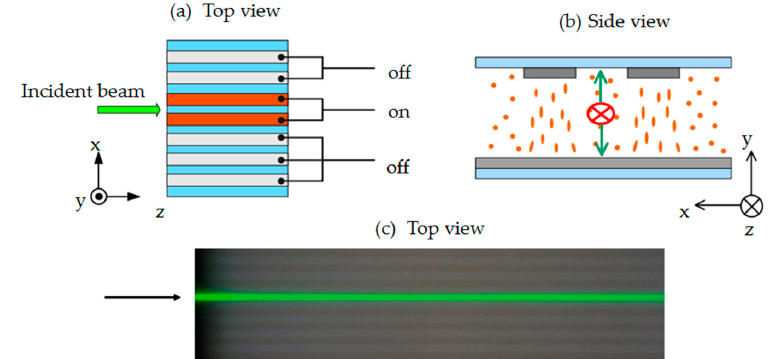
Figure 5. The incident beam is introduced into a non-electrode channel, ( a ) top view and ( b ) back view of the schematics for the incident beam and the sample schematic. ( c ) The top view image captured by camera.